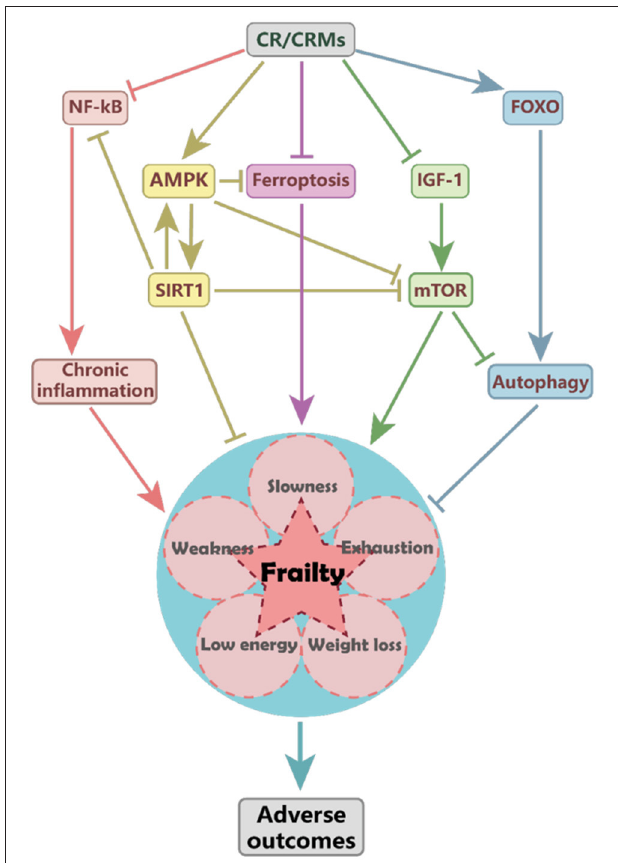
FIGURE 1 | The proposed mechanism of caloric restriction (CR) impacts frailty. CR may reduce the risk of frailty and associated adverse outcomes by activating the AMPK and SIRT1 pathways, inhibiting the IGF-1 and mTOR signaling and ferroptosis, and reducing the inflammation mediated by NF-KB pathways. CR-induced SIRT1 activation may upregulate AMPK and suppress NF- κ B and mTOR activity. CR and metformin may attenuate ferroptosis by activating the AMPK pathway and improving frailty. AMPK, adenosine 5 ′ -monophosphate (AMP)-activated protein kinase; CR, caloric restriction; CRMs, caloric restriction mimetics; FOXO, forkhead box O; IGF-1, insulin-like growth factor-1; mTOR, mammalian target of rapamycin; NF- κ B, nuclear factor- κ B; SIRT1, silent mating-type information regulation 2 homolog